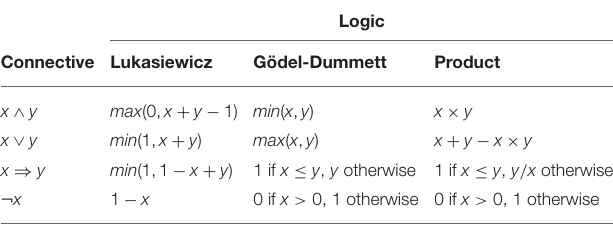
TABLE 2 | Definitions of logic connectives for the three main fuzzy